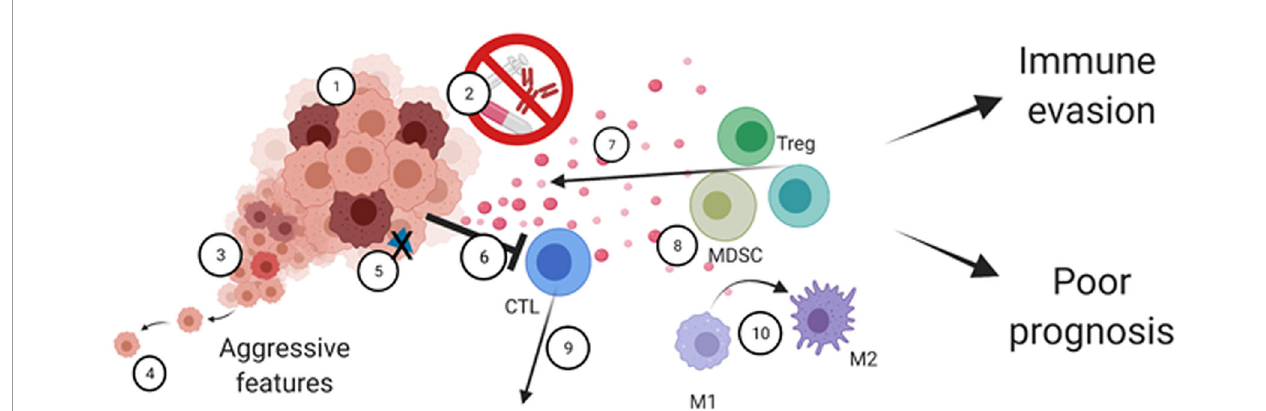
FIGURE 3 | The multifaceted roles of AXL in the tumor-immune microenvironment. AXL signaling regulates cancer cell-intrinsic properties such as 1) Tumor cell growth and survival, 2) therapy resistance, 3) cancer cell plasticity mediating cancer heterogeneity and 4) increased cell motility. AXL can also mediate cancer cell immune escape through 5) decreased antigen presentation and by 6) resisting immune cell killing. AXL also mediates remodeling of the tumor microenvironment by 7) secretion of immunosuppressive cytokines and chemoattractants, 8) recruitment of immunosuppressive cells, including MDSCs and Tregs, 9) decreased in fi ltration of activated immune cells including cytotoxic T-cells, and 10) M1 to M2 polarization. Ultimately, this leads to tumor immune evasion and poor